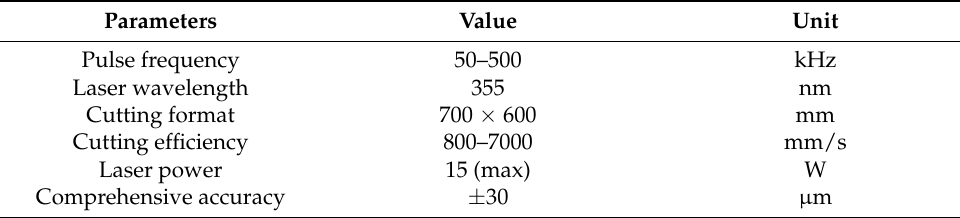
Table 1. Specific parameters of nanosecond laser equipment.